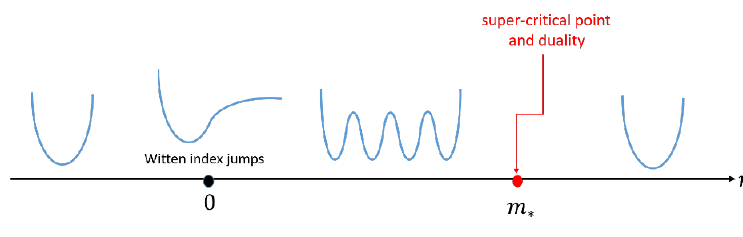
Figure 1 . Schematic general form of the phase diagram for the N = 1 gauge theories with CS terms and N f fundamental matter (cid:12)elds discussed in this paper. The blue graphs depict the e(cid:11)ective potential. There are two semiclassical phases for large j m j , and an intermediate phase with min( N + 1 ; N f + 1) solutions to the F-term equations with various symmetry breaking patterns. A similar phase diagram exists for SO( N ) and Sp( N ) gauge groups. The phase transition at m = m (cid:3) is highly unnatural, since at this point many solutions of the F-term equations collide simultaneously. Nonetheless, this picture is an exact result to all orders in perturbation